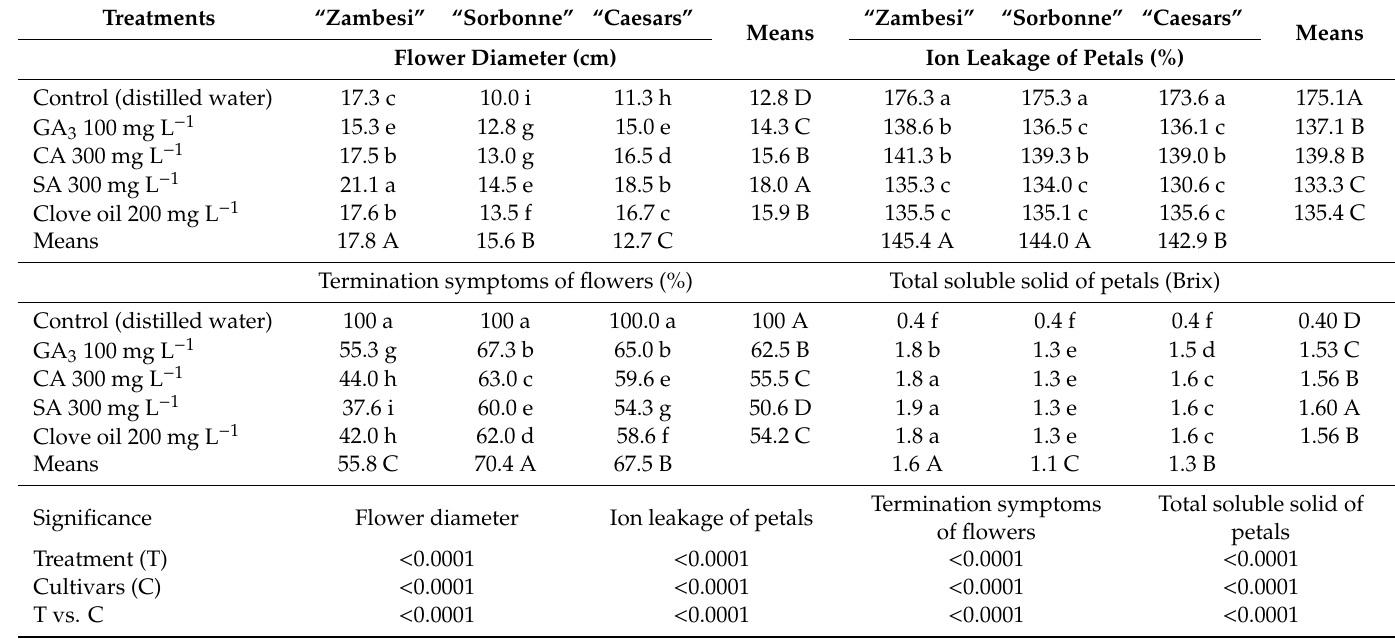
Table 2. Comparative analysis of the e ff ects of di ff erent vase solutions on the flower diameter, ion leakage of petals, termination symptoms of flowers, and total soluble solid of petals of three cultivars of cut lily